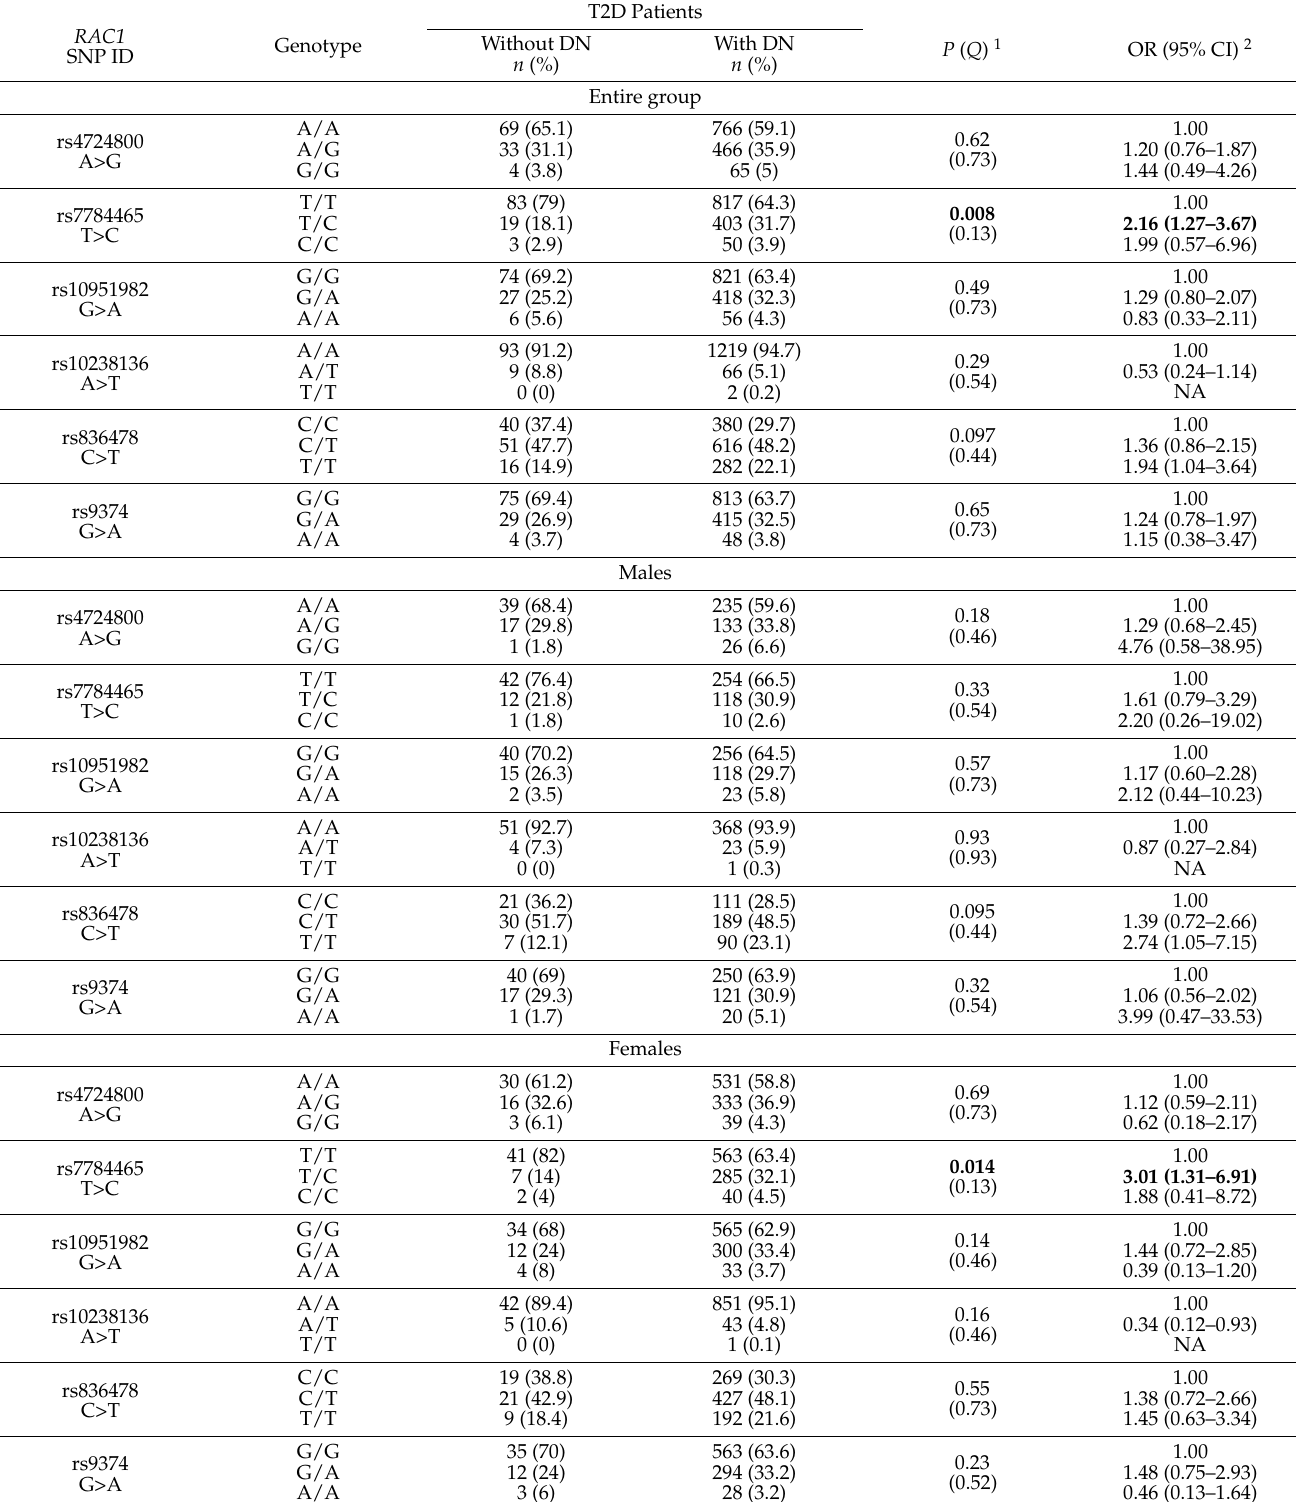
Table 5. Genotype frequencies for the studied gene polymorphisms among T2D patients with and without diabetic